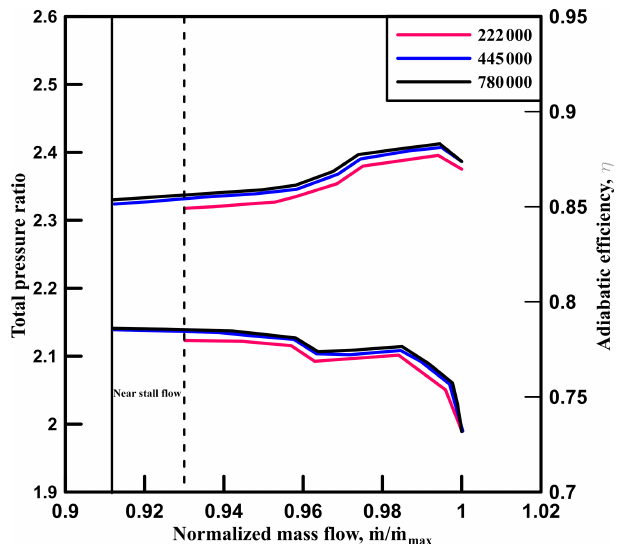
Figure 4. Influence of the number of grids on the characteristic map of the compressor.